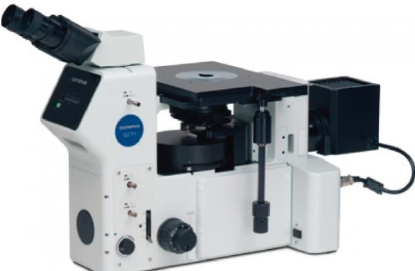
Figure 3: Optical microscope.